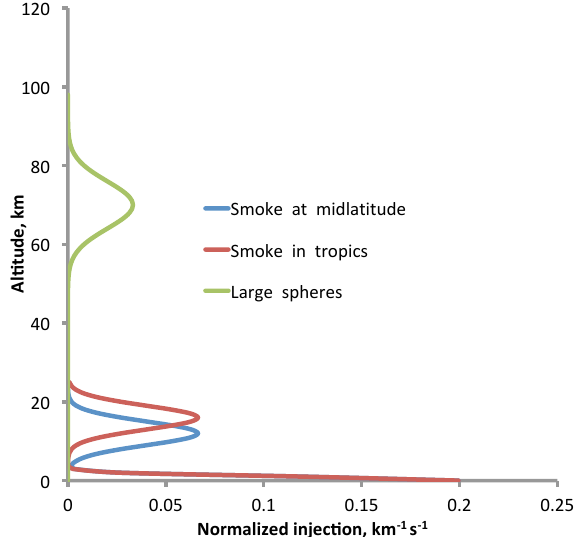
Figure 1. Injection profiles for smoke at midlatitudes and the tropics and for large spherical particles. Many other constituents follow the same vertical profiles as noted in Tables 1–4. We suggested clastics be placed above the tropopause using a constant mixing